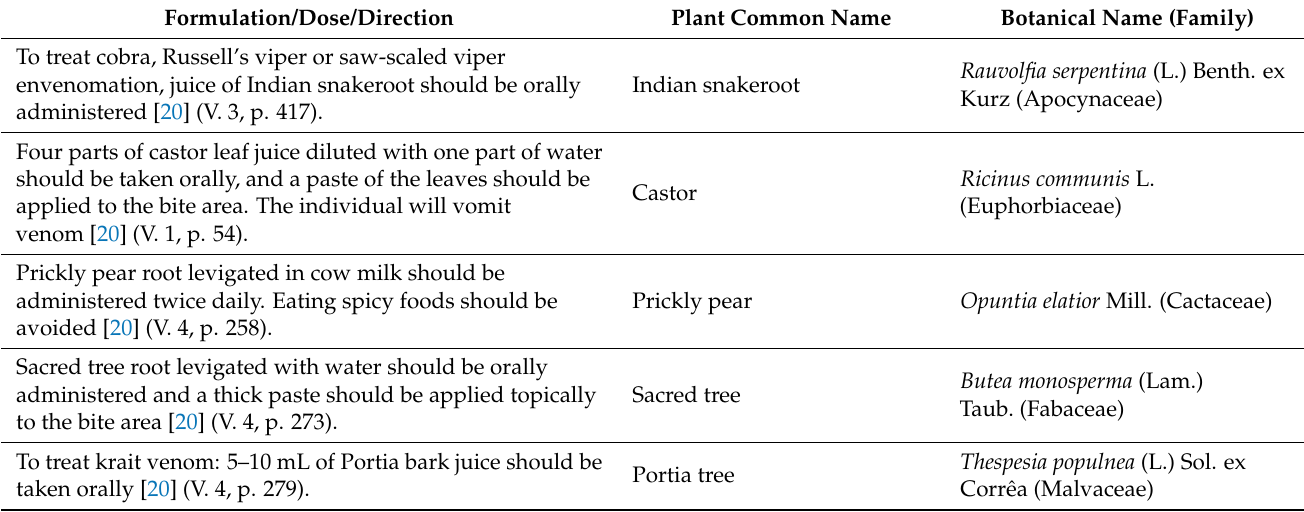
Table 1. Snake-bite therapies comprising single plant